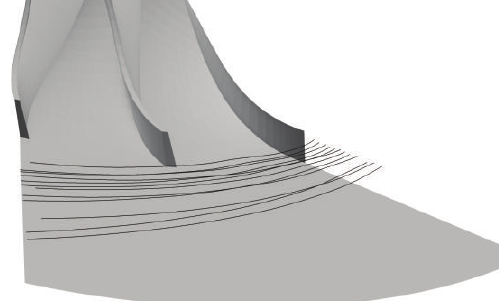
Figure 11: Streamlines near the impeller exit 𝑏/𝑏 2 = 0.85 .